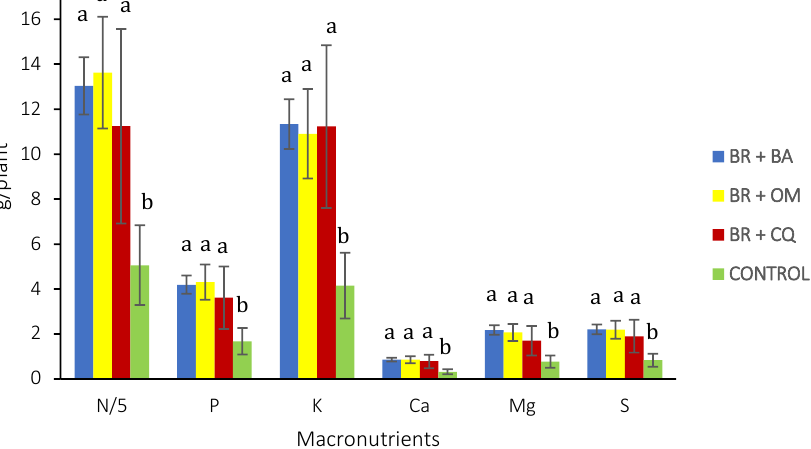
Figure 4. Macronutrients content of grains. Different letters mean statistically significant differences (value p ≤ 0.05) in LSD Test ( ± Standard deviation). (N/5): N value was divided by 5 so that they could be included with the rest of the data in the same graphic.